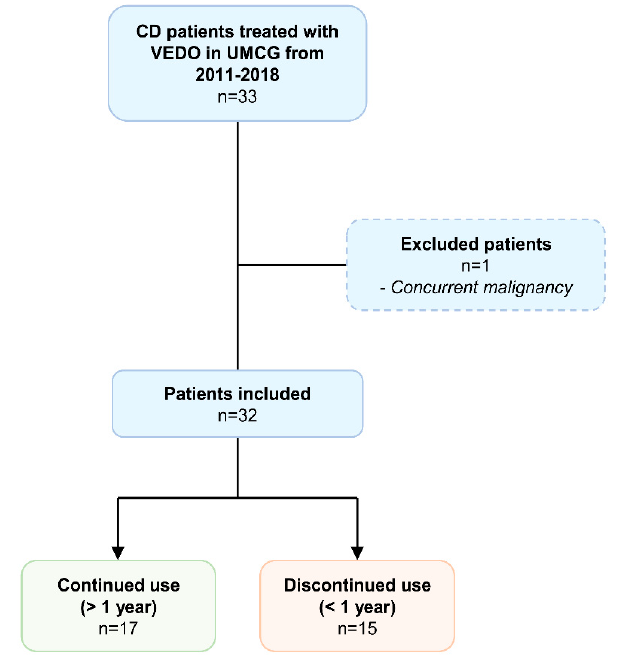
Figure 4. Patient inclusion flowchart.